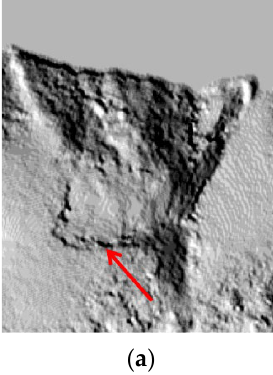
Figure 12. Landslide area: ( a ) TanDEM-X shaded DEM; ( b ) Optical Google Earth image before the event; ( c ) Optical Google Earth image after the event. Arrows mark the main scarp location.